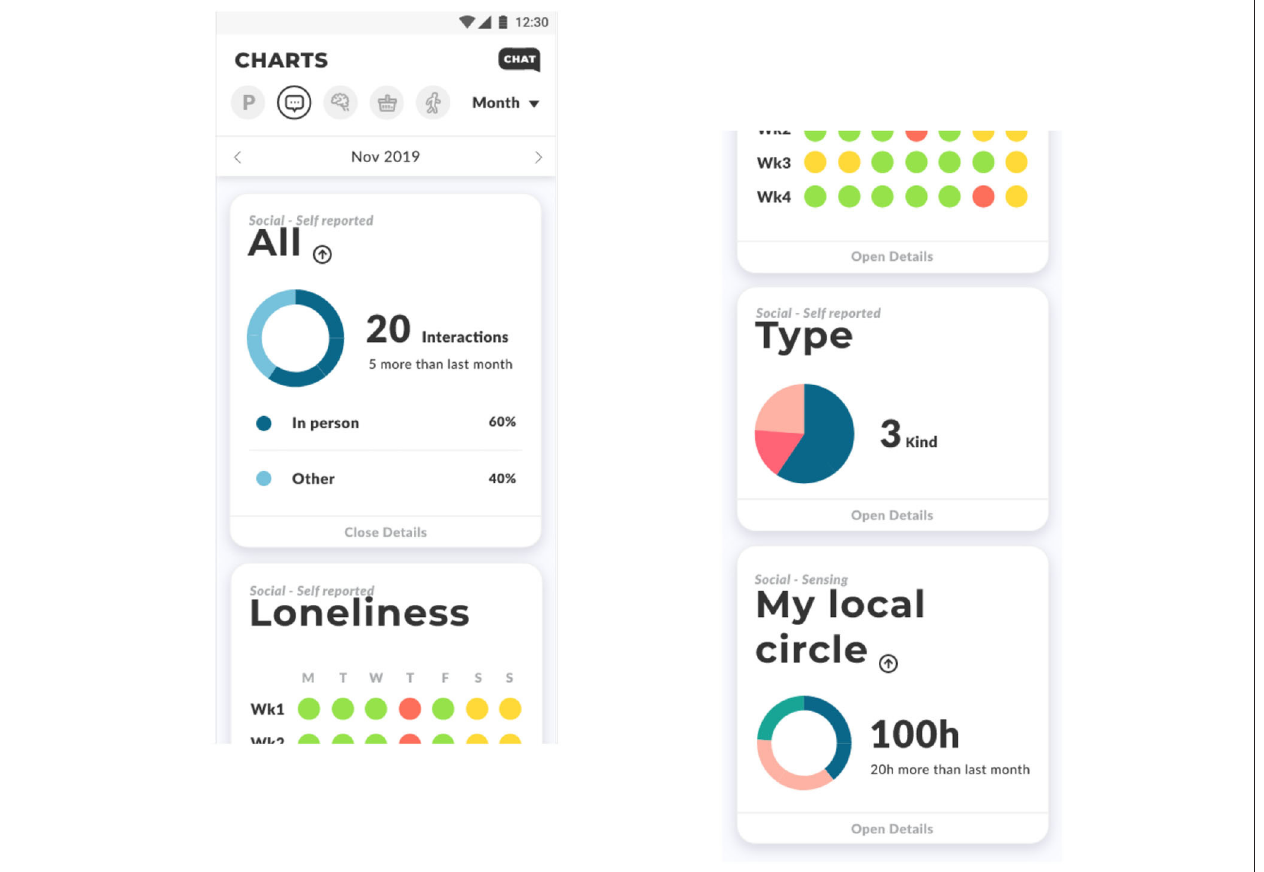
FIGURE 9 | Feedback on the Social domain via the app